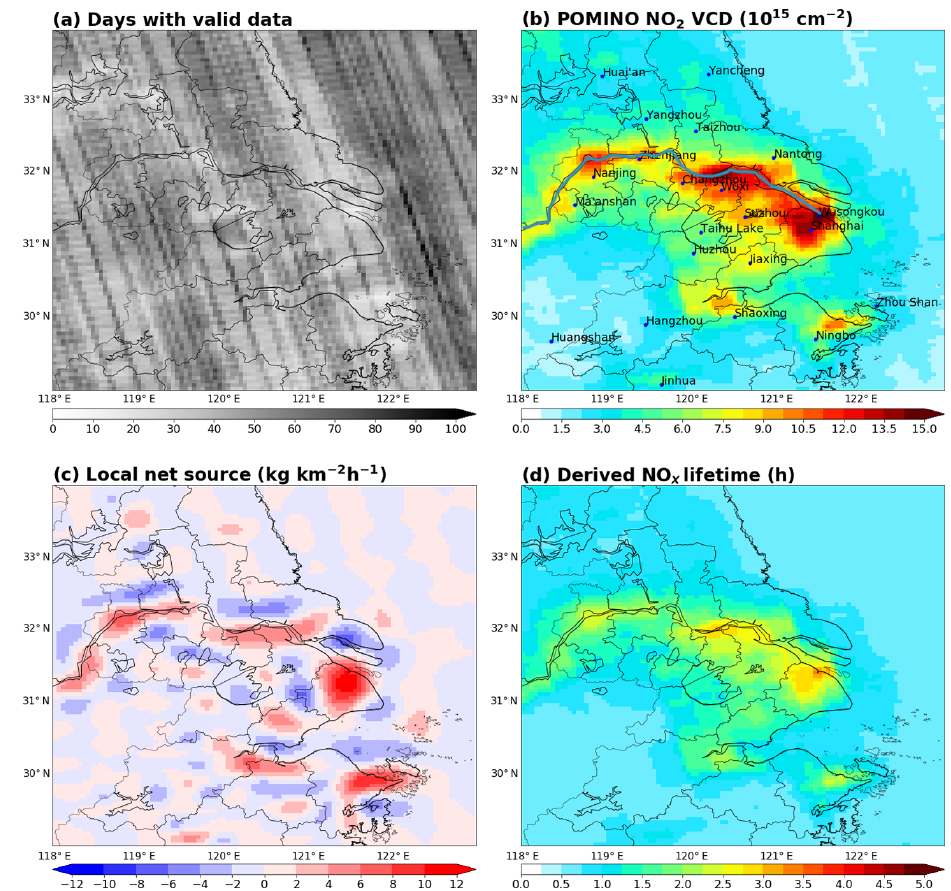
Figure 3. (a) Number of days with valid data in each grid cell over the summer months of 2012–2015. (b) POMINO NO 2 VCDs averaged over the summer months 2012–2015. Cities and locations mentioned in this paper are denoted. The Yangtze River is marked as a blue line. (c) Derived local net source. (d) Derived NO x lifetime due to both chemical loss and